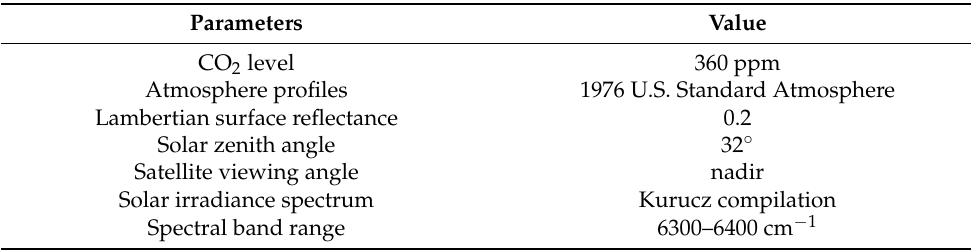
Table 3. Input parameters of radiance simulation for